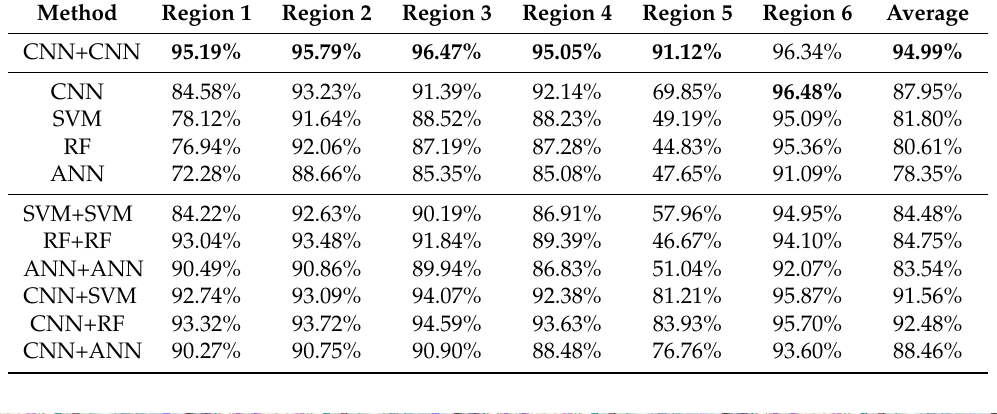
Table 9. Summary of the detection results of all methods in terms of F1-score.